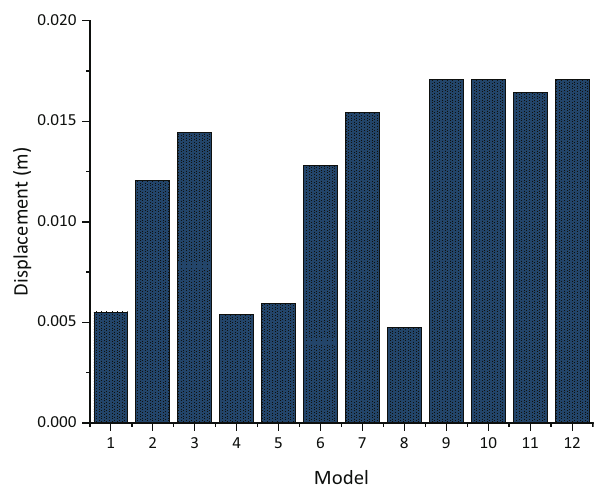
Figure 18: Average displacement value for every